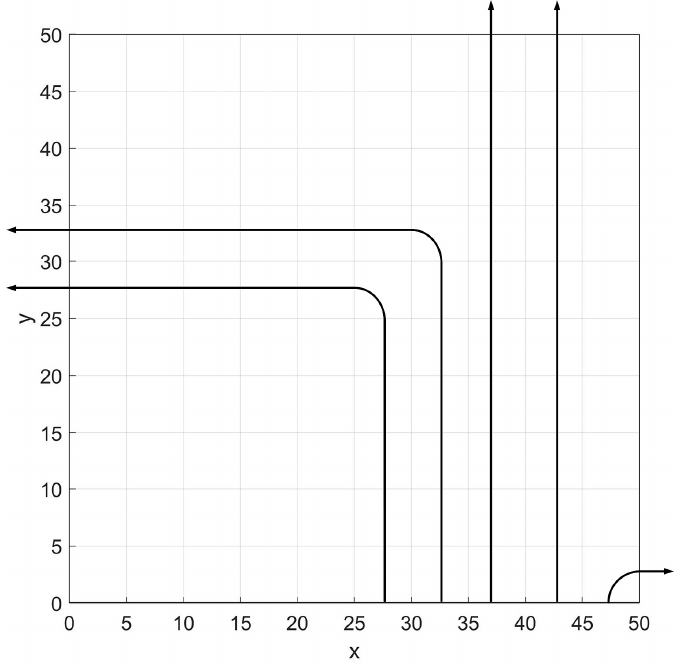
Figure 3. Allowed paths of UAVs based on entrance lane. The allowed movements in the 3D intersection are shown in Figure 4. The allowed movements are left turn, move forward, right turn, move downward then turn left, move downward then forward, move upward then turn left, and move upward then